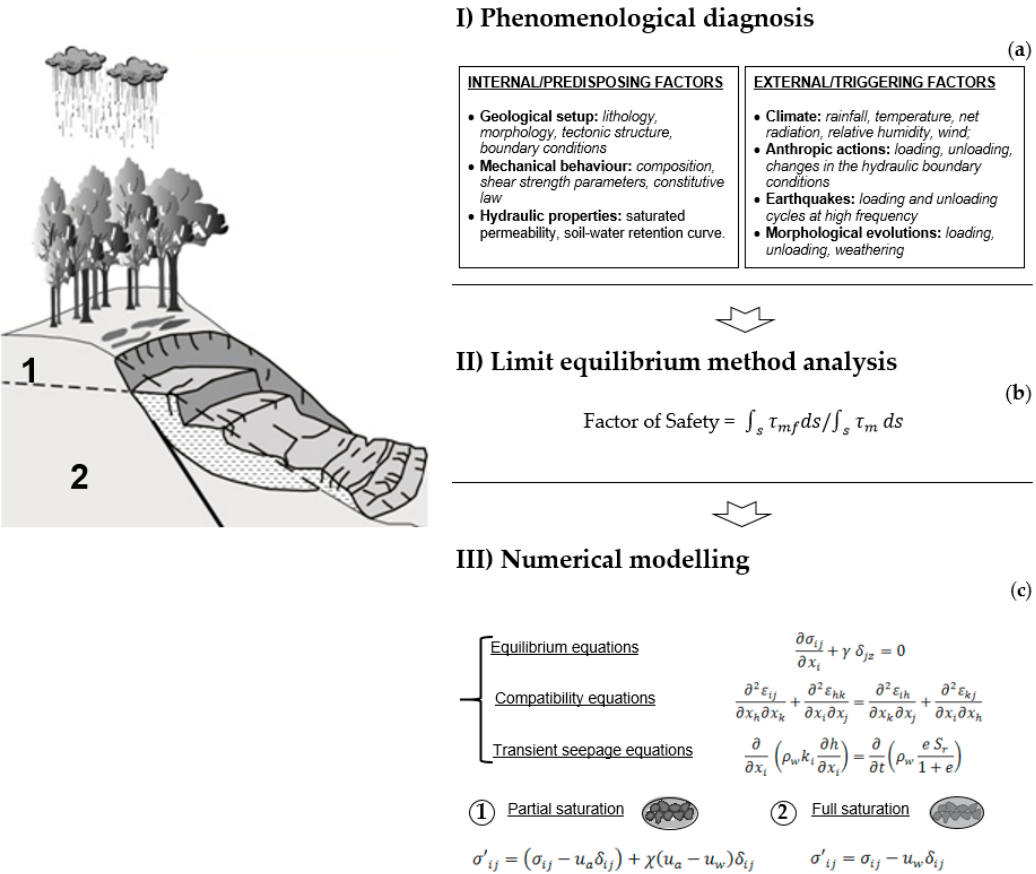
Figure 5. The stage-wise methodology for the GHM characterization of the landslide mechanisms [10]. ( a ) Phenomenological diagnosis, I level of analysis; ( b ) limit equilibrium method, II level of analysis; ( c ) numerical modelling, III level of analysis.